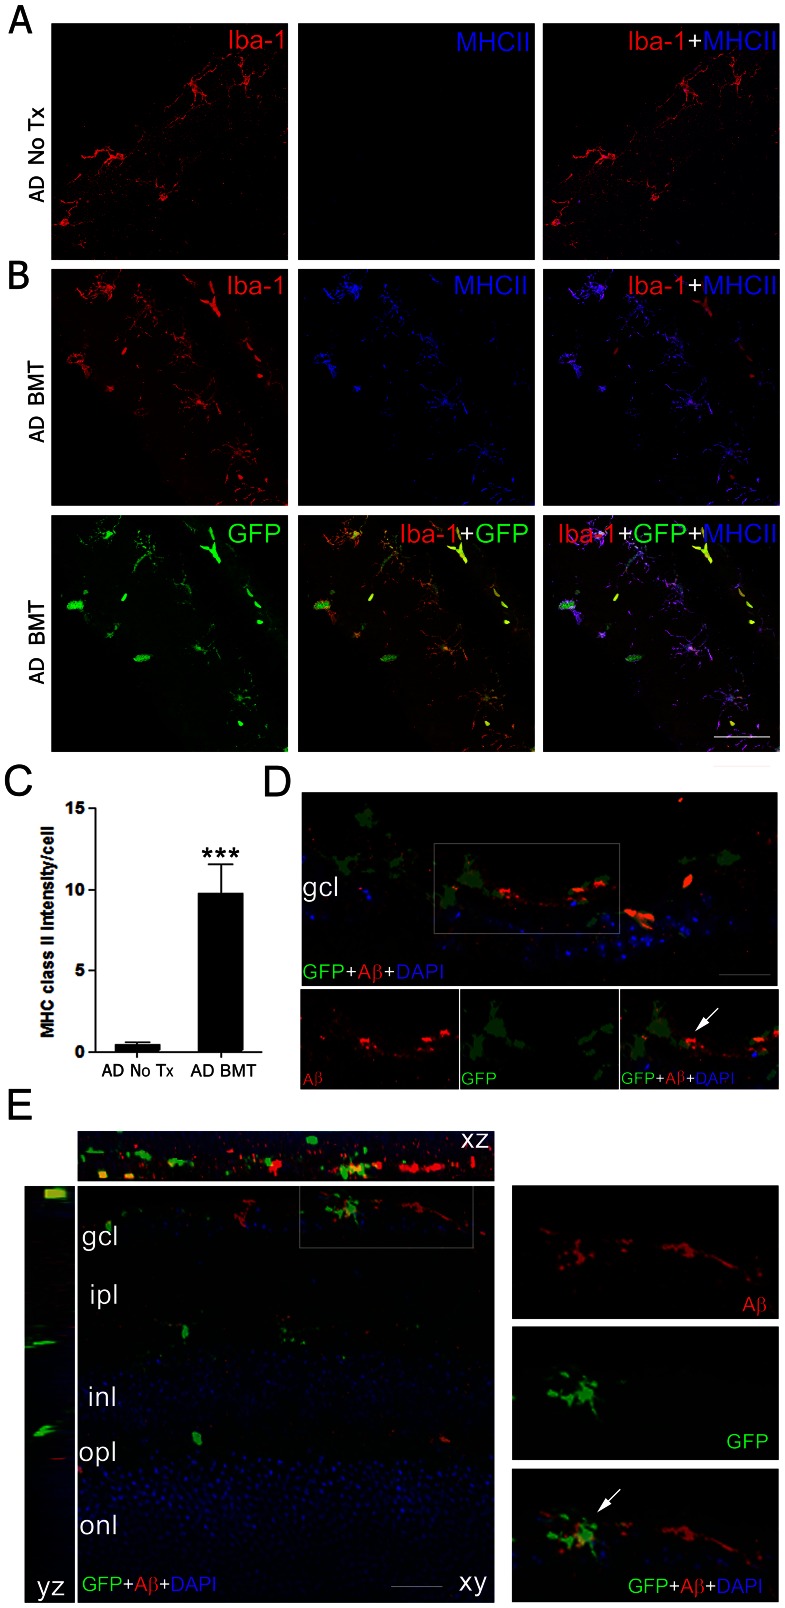
MHC class II is up-regulated in BMT-derived retinal microglia.
A: Representative photomicrographs of microglia in the retina of a 13-month-old non-transplanted wt mouse stained with anti-Iba-1 antibody and visualized with Cy3-conjugated secondary antibody (red). The endogenous Iba-1+ microglial cells do not express detectable MHC class II by immunofluorescence stains (blue, overlay with Cy3 fluorescence) in untreated (No Tx) wt retina. B: Representative photomicrographs of retinal sections from a 13-month-old wt mouse transplanted with GFP+ BM cells. Immunofluorescence staining demonstrates that the Iba-1+ microglia (red) are almost completely derived from the BMT (green GFP+ cells). GFP+ cells were strongly immunoreactive for MHC class II (blue). The overlay of the confocal microscope images indicates co-expression of GFP (green), Iba-1 (red) and MHC class II (blue) in retina. Scale bar  = 30 μm. C: Quantification of MHC class II immunofluorescence in microglia shows significantly increased expression in BM-derived cells compared with the endogenous microglia. ***P<0.001, n = 6, student's t test. D: Confocal analysis of sections demonstrates association of BM-derived microglia (GFP+, green, arrow) and Aβ deposits (red). High magnification of inset is shown on the lower panels. Scale bar: 20 µm. E: 3D-Confocal image analysis of intracellular Aβ in BM-derived microglia. The overlay of confocal images reveals Aβ deposition (red) within GFP+ BM-derived microglia (green, arrow). High magnification of inset is shown on the right panels. Scale bar: 20 µm.